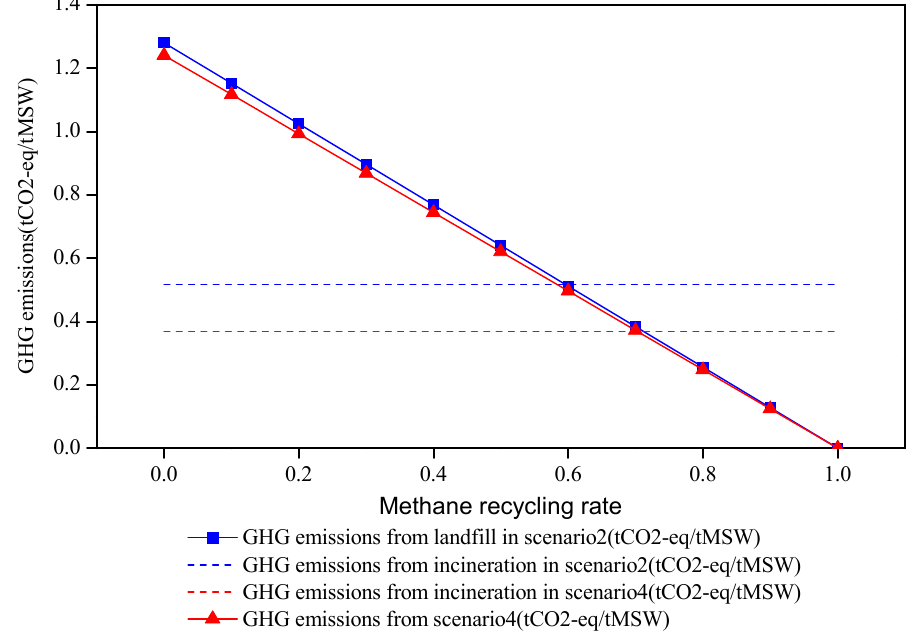
Figure 11. GHG emissions from MSW landfill for di ff erent methane recycling rate.